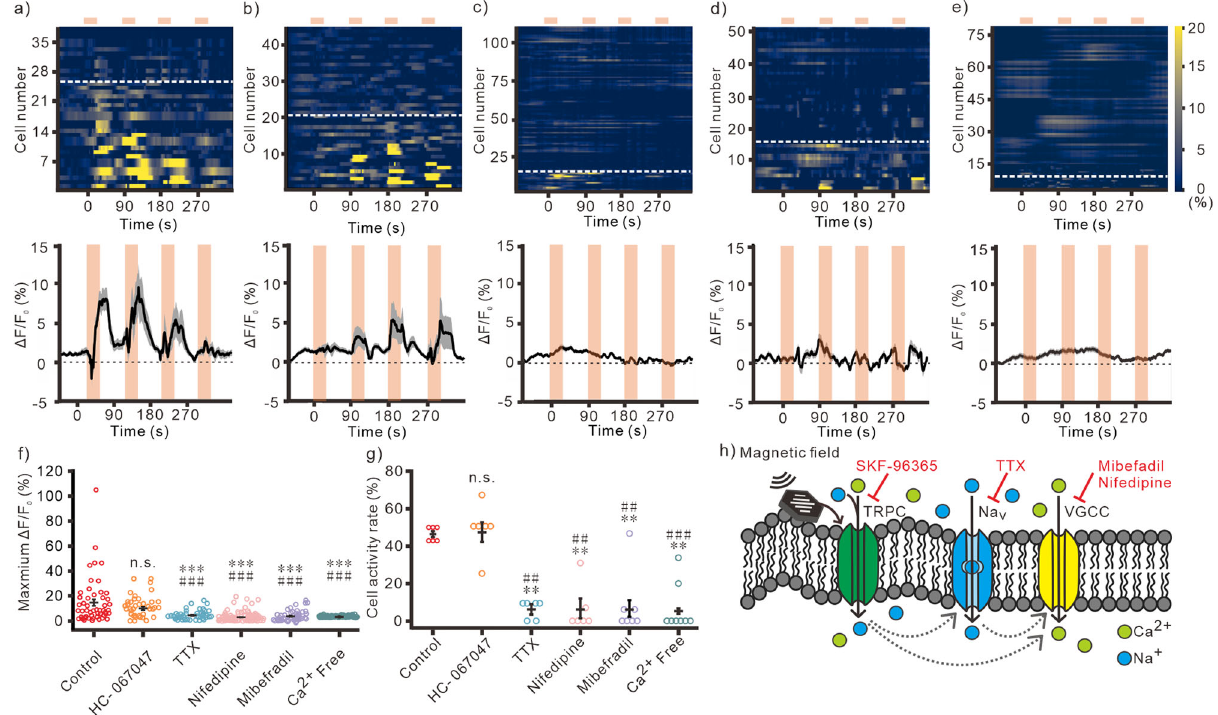
Fig. 5 Pharmacological dissection of magnetomechanical stimulated responses in neurons. The Ca 2 + responses by multiple magnetomechanical stimulation with bath application of HC-067047 at 1 μ M ( a , n = 38/6 (neurons/samples)), TTX at 100 nM ( b , n = 44/6), Nifedipine at 10 μ M ( c , n = 107/6), Mibefradil at 3 μ M ( d , n = 50/7), and Ca 2 + -free solution ( e , n = 79/8). The magnetic stimulations are 50mT at 10Hz for 30s. Inter-stimulation intervals are 60s. top, heatmap of individual cells ’ responses. The cells below white dash lines were activated during stimulations. bottom, averaged fl uorescence changes. The light orange areas indicate the time periods of magnetic stimulation. The gray areas are s.e.m. f The maximum fl uorescence changes at the fi rst magnetic stimulation (Control, n = 52/6 (neurons/samples); HC-067047, n = 38/6; TTX, n = 44/6; Nifedipine, n = 107/6; Mibefradil, n = 50/7; Ca 2 + -free, n = 79/8). F = 135.911, p <0.001, Kruskal-Wallis test. g The cell activity rate at the fi rst magnetic stimulation (Control, n = 6; HC-067047, n = 6; TTX, n = 6; Nifedipine, n = 6; Mibefradil, n = 7; Ca 2 + -free, n = 8). F = 30.674, p <0.001, Kruskal-Wallis test. h Schematic for the mechanism of MND mediated responses. ** p